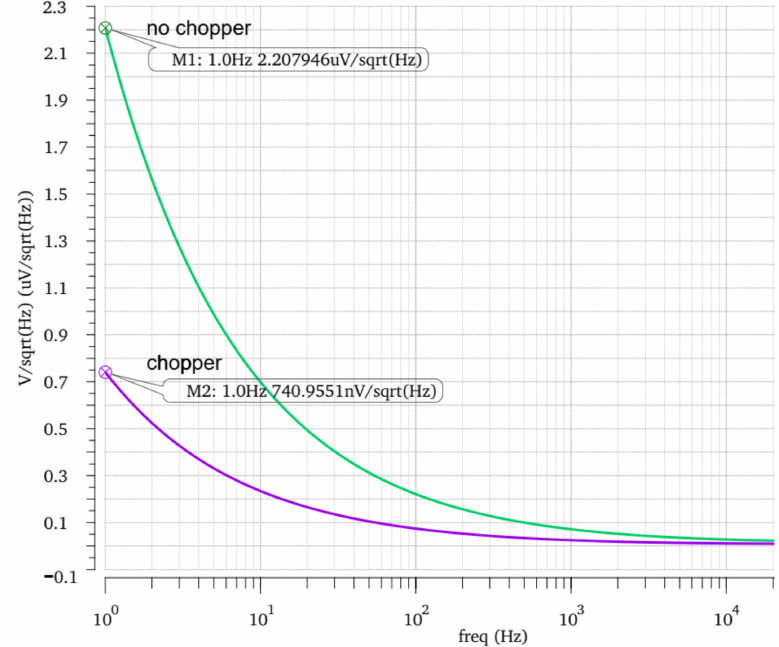
Figure 12. Post-simulation of system noise